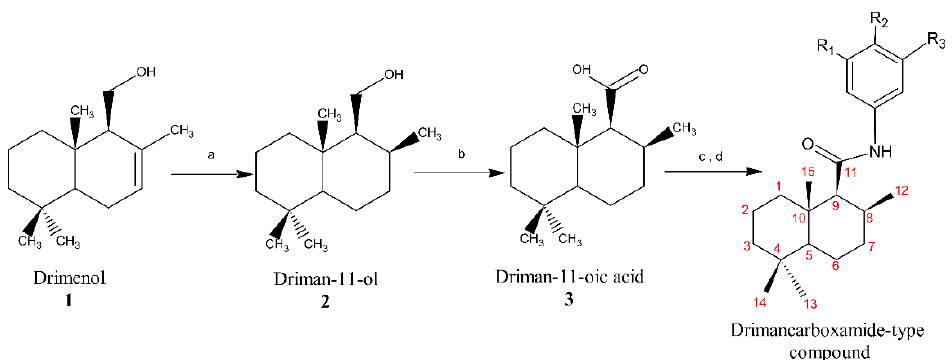
Figure 1. Route of synthesis of drimancarboxamide -type compounds. a. H 2 , Pd/C; b. acetone; CrO 3 , H 2 SO 4 ; c. SOCl 2 , DMF; d. aniline, triethylamine, CH 2 Cl 2